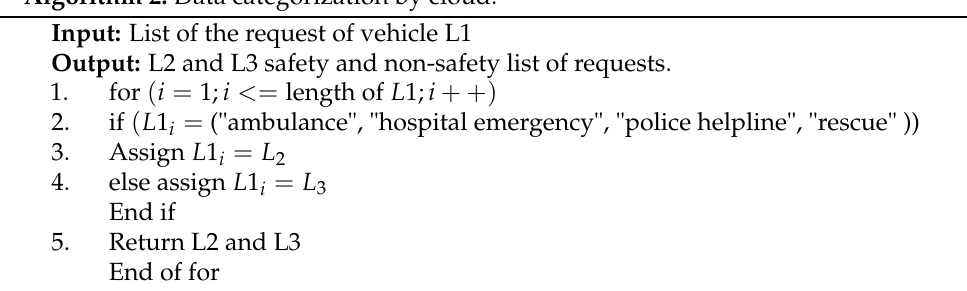
Algorithm 2: Data categorization by cloud.